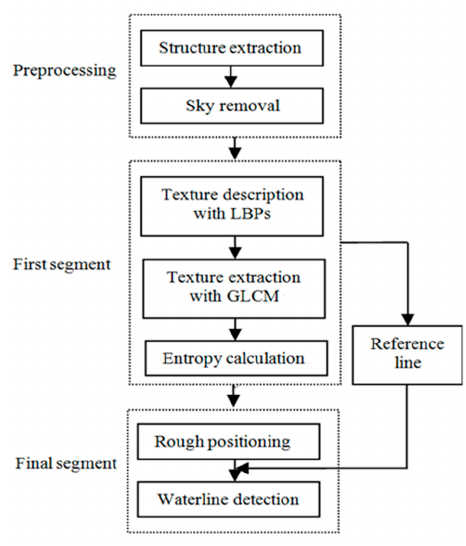
Figure 13. The flow of our detection algorithm.